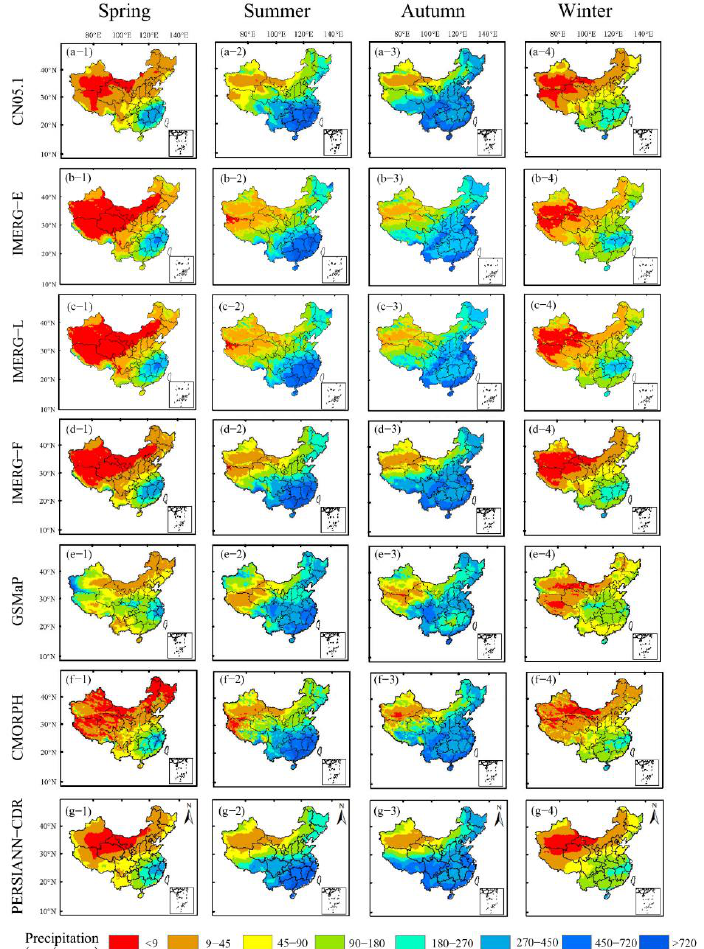
Figure 6. Comparisons of spatial distributions of seasonal average precipitation (mm/day) between six satellite products and ground interpolation product (CN05.1): ( a–1 )–( a–4 ) represent spatial distributions of mean precipitation for CN05.1 from spring to winter, respectively; ( b–1 )–( b–4 ) represent four seasons for IMERG–E; ( c–1 )–( c–4 ) represent four seasons for IMERG–L; ( d–1 )–( d–4 ) represent four seasons for IMERG–F; ( e–1 )–( e–4 ) represent four seasons for GSMaP; ( f–1 )–( f–4 ) represent four seasons for CMORPH; and ( g–1 )–( g–4 ) represent four seasons for PERSIANN–CDR. Specifically, the different satellite products presented different precipitation charac- teristics. Compared with the ground interpolation product of CN05.1, the estimates of IMERG products were drier in spring and winter for the Tibetan Plateau and northwest